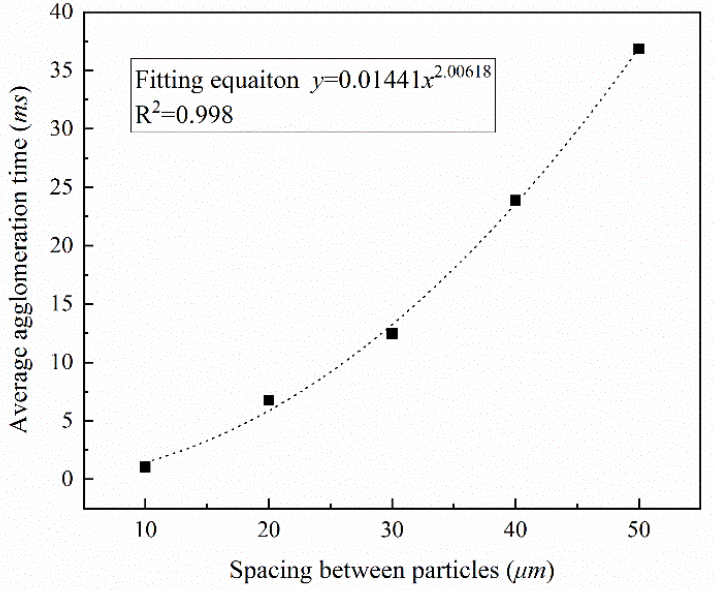
Figure 14. Variation of average agglomeration time with droplet spacing. The average agglomeration time increased as the aerosol droplet particle spacing increased. When the particle spacing was increased to 50 µ m, the average agglomera- tion time was about 5.5 times the value observed for the case with a droplet spacing of 20 µ m. It can be inferred that under actual conditions, the average agglomeration time will increase